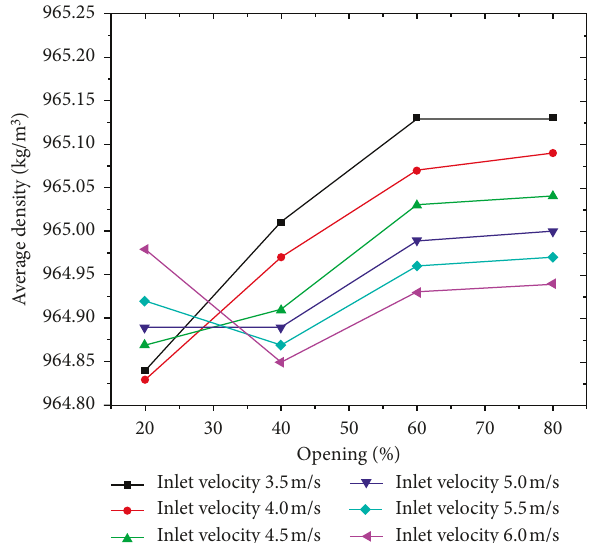
Figure 43: Variation of temperature-constant openness and av- erage density with inlet